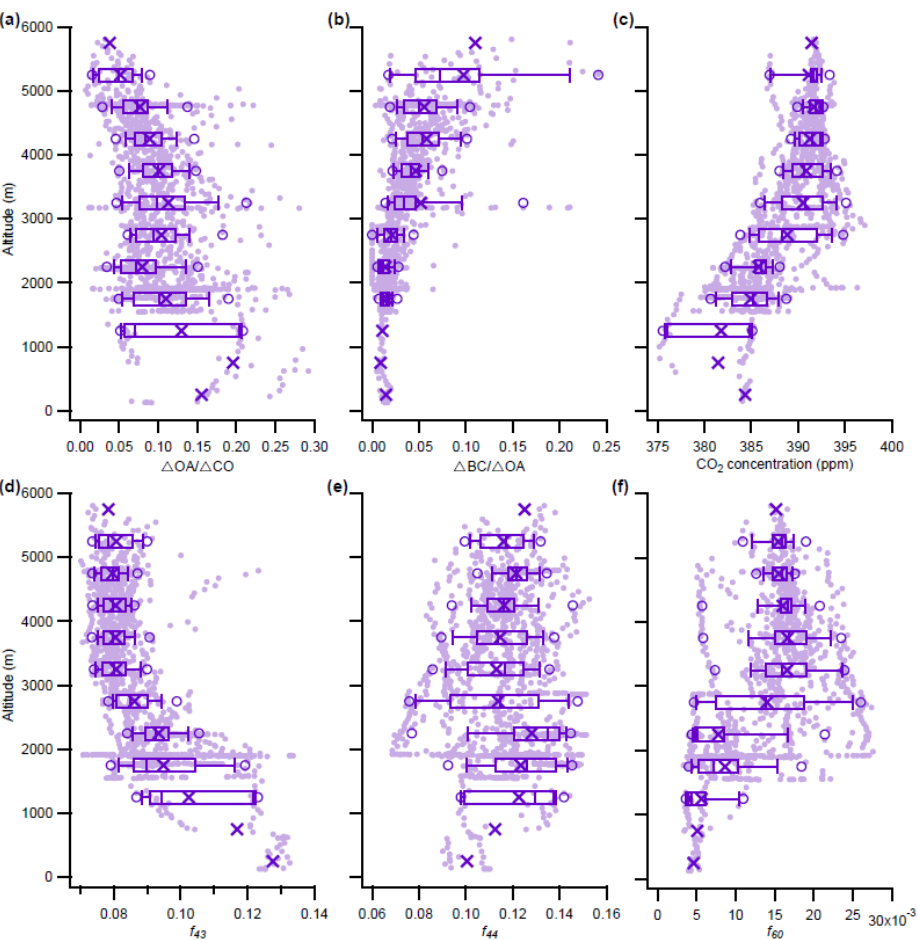
Figure 5. Vertical profiles of (a) (cid:49) OA /(cid:49) CO, (b) (cid:49) BC /(cid:49) OA, (c) CO 2 , (d) f 43 , (e) f 44 and (f) f 60 in aged plumes. Circles represent the 5th and 95th percentiles, vertical lines the 10th, 25th, 50th, 75th and 90th percentile, with crosses denoting mean values in each 500m altitudinal